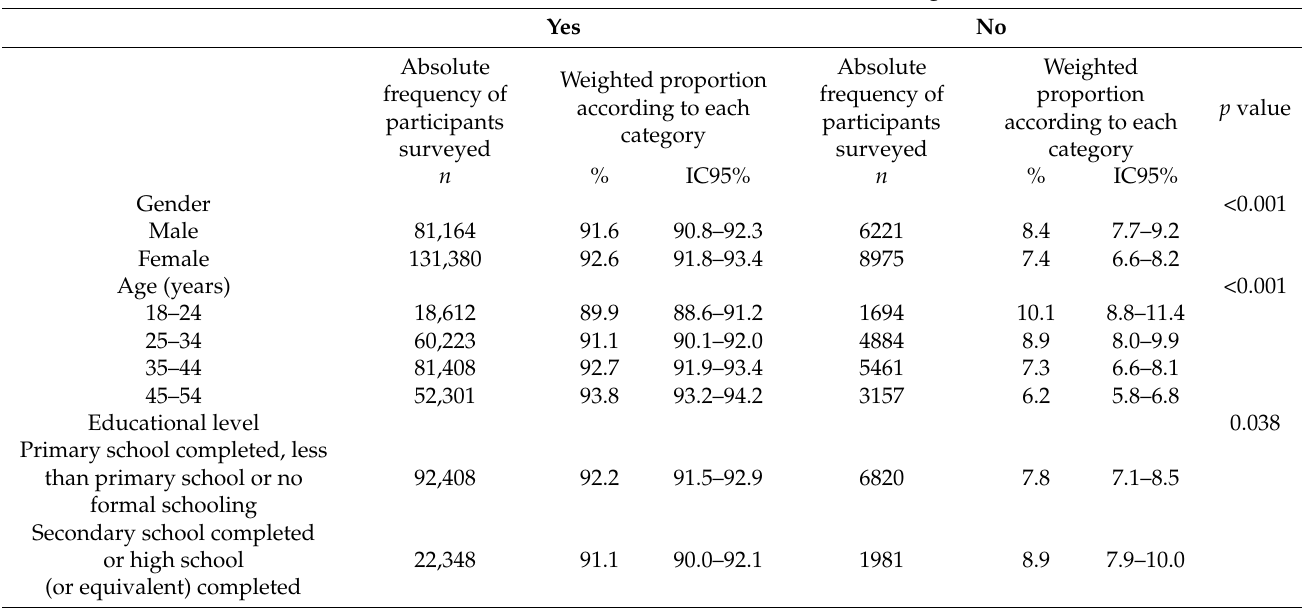
Table 2. Characteristics according to parents’ intention to vaccinate their children against COVID-19 ( n = 227,740; N =